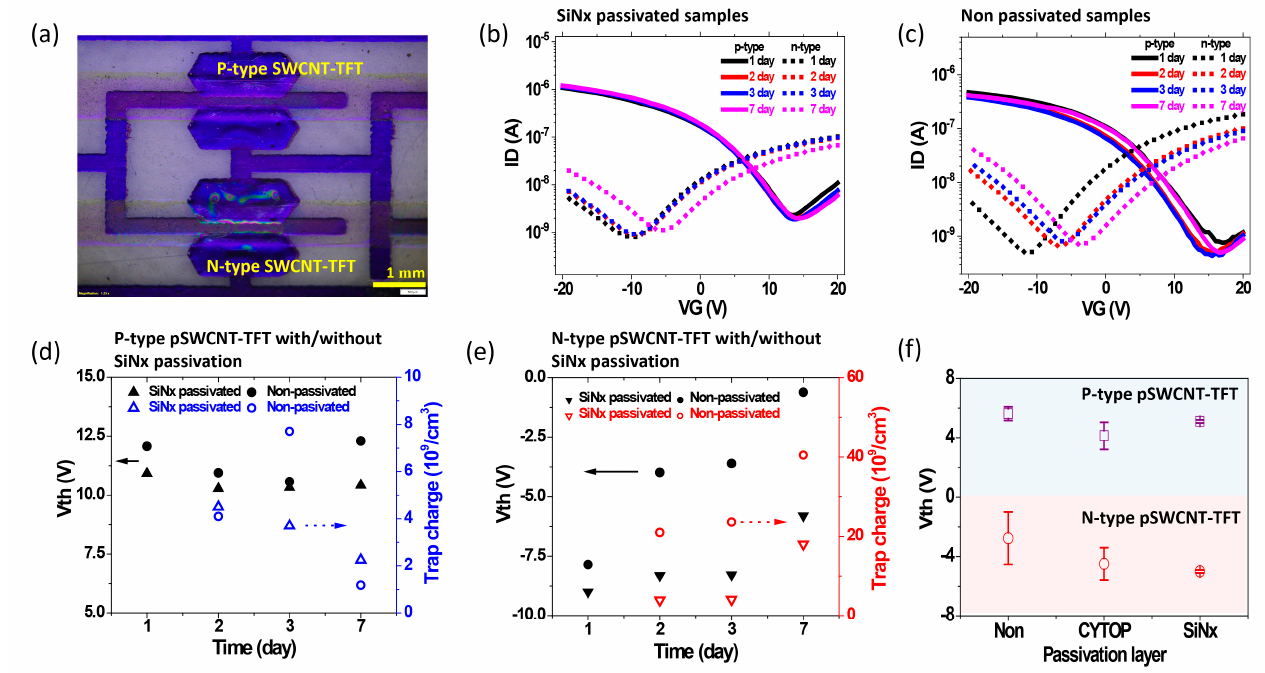
Figure 2 . Single pSWCNT ‐ TFT device characterization before/after SiNx passivation process. ( a ) Optical image of SiNx ‐ passivated p ‐ type and n ‐ type pSWCNT ‐ TFTs. Transfer characteristics of printed p-type and n-type SWCNT-TFTs ( b ) with passivation and ( c ) without SiNx R2R ‐ printed p ‐ type and n ‐ type SWCNT ‐ TFTs ( b ) with passivation and ( c ) without SiNx passivation (200 nm thickness). The plot of Vth and trapped charge density variations with and without SiNx passivation layer of ( d ) p ‐ type and ( e ) n ‐ type pSWCNT ‐ TFTs as a function of time. ( f ) Vth variation graph of bare (non ‐ passivated), CYTOP ‐ passivated, and SiNx ‐ passivated p ‐ type and n ‐ type pSWCNT ‐ TFTs.